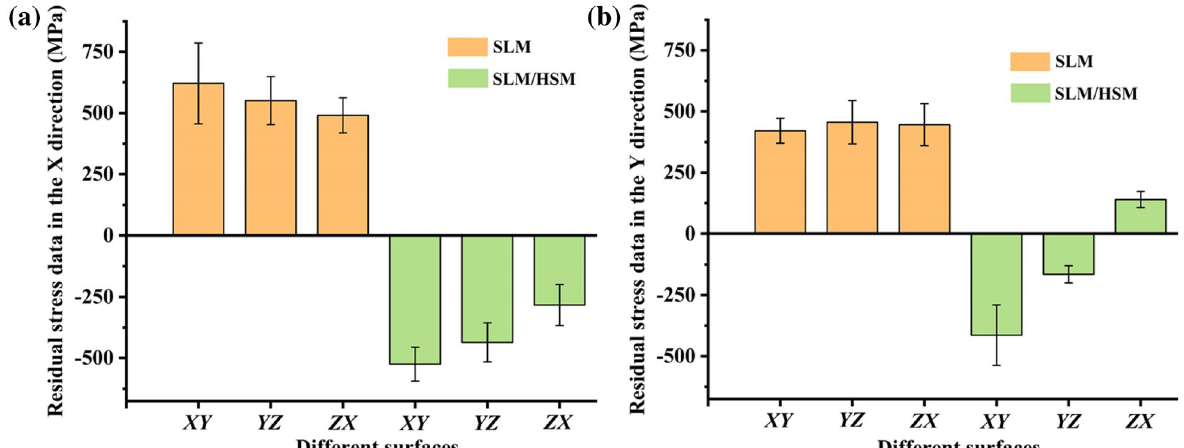
Figure 15 Residual stress of SLMed and SLMed/HSMed samples: a Residual stress in the X direction; b Residual stress in the Y direction